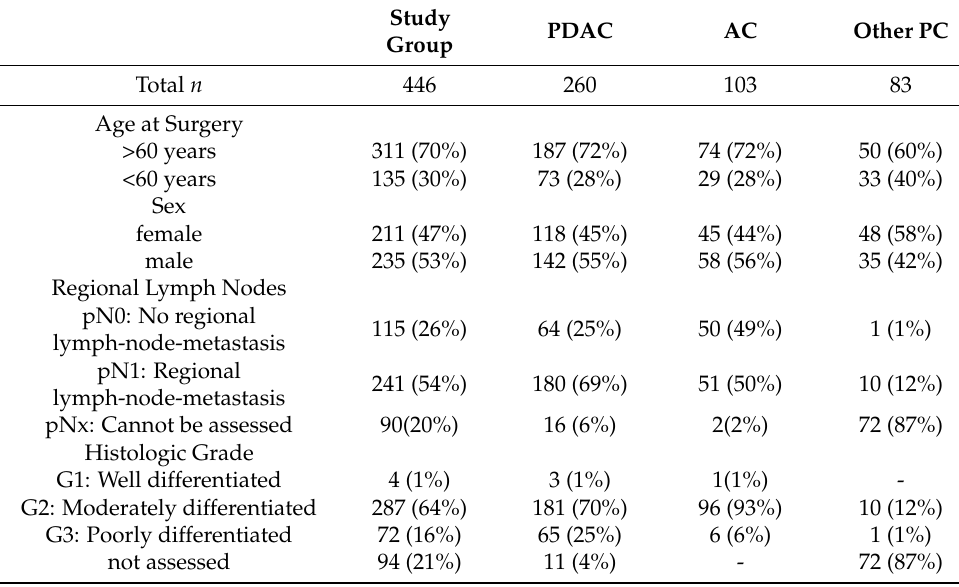
Table 1. Clinicopathological characteristics of our patient